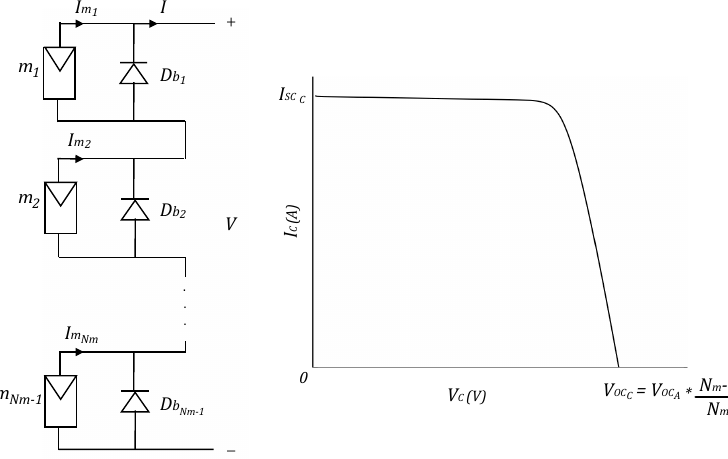
≈ 0 A ). Right : PV module Nm